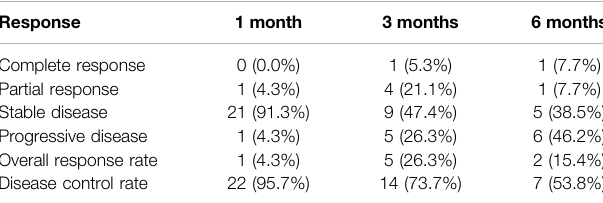
TABLE 3 | Local tumor response assessed using RECIS